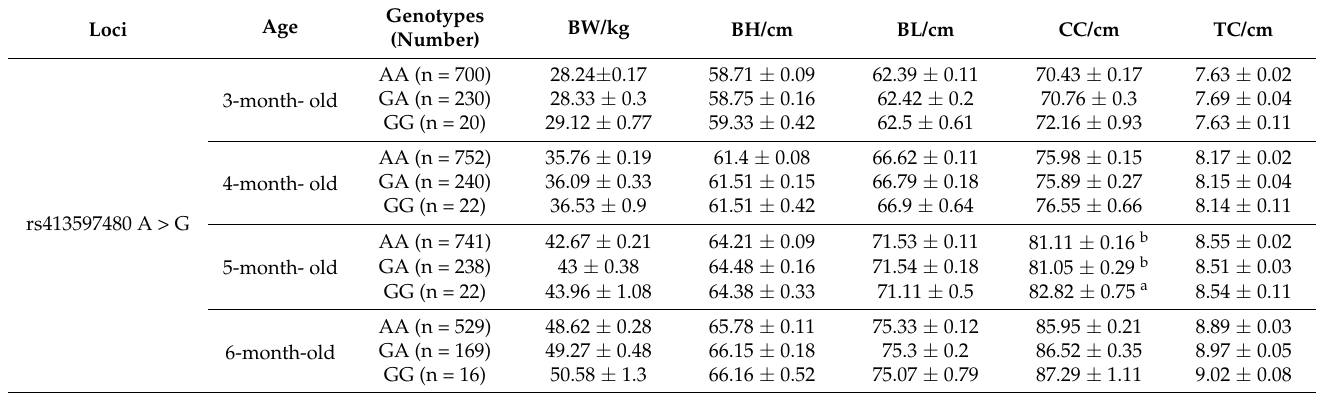
Table 4. Association analysis between the ARNT gene polymorphisms and growth traits (BW, BH, BL, CC, and TC) of Hu sheep from 3-month-old to 6-month-old.